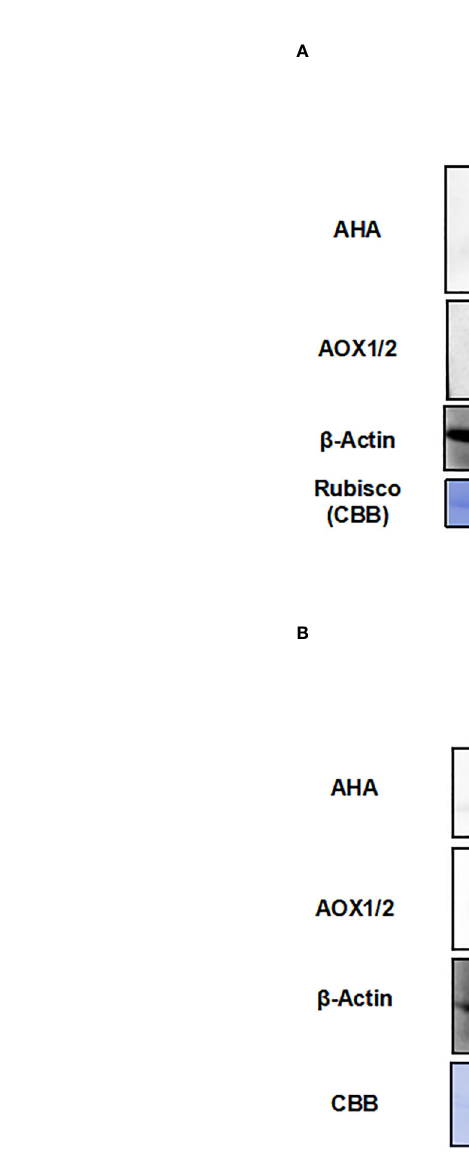
FIGURE 2 Immunoblot analysis for different fractions with antibodies against subcellular marker proteins. The proteins of leaf and root tissue from steps of the enrichment procedure were analyzed by immunoblotting with organelle speci fi c markers (T, total homogenate; Cyto, cytosolic fraction; CM, crude microsomal fraction; PM, plasma membrane-enriched fraction). (A) Equal amounts of proteins of leaves from each fraction were analyzed by immunoblotting with two antibodies against organellar marker proteins (PM marker: AHA; mitochondrial marker: AOX1/2; cytosolic maker: b - actin). (B) Equal amounts of proteins of roots from each fraction were analyzed by immunoblotting with antibodies against AHA, AOX1/2 and b - actin. PM, plasma membrane; AHA, H+-ATPase; AOX1/2, Plant alternative oxidase 1 and 2. Total protein loads were detected by coomassie blue staining